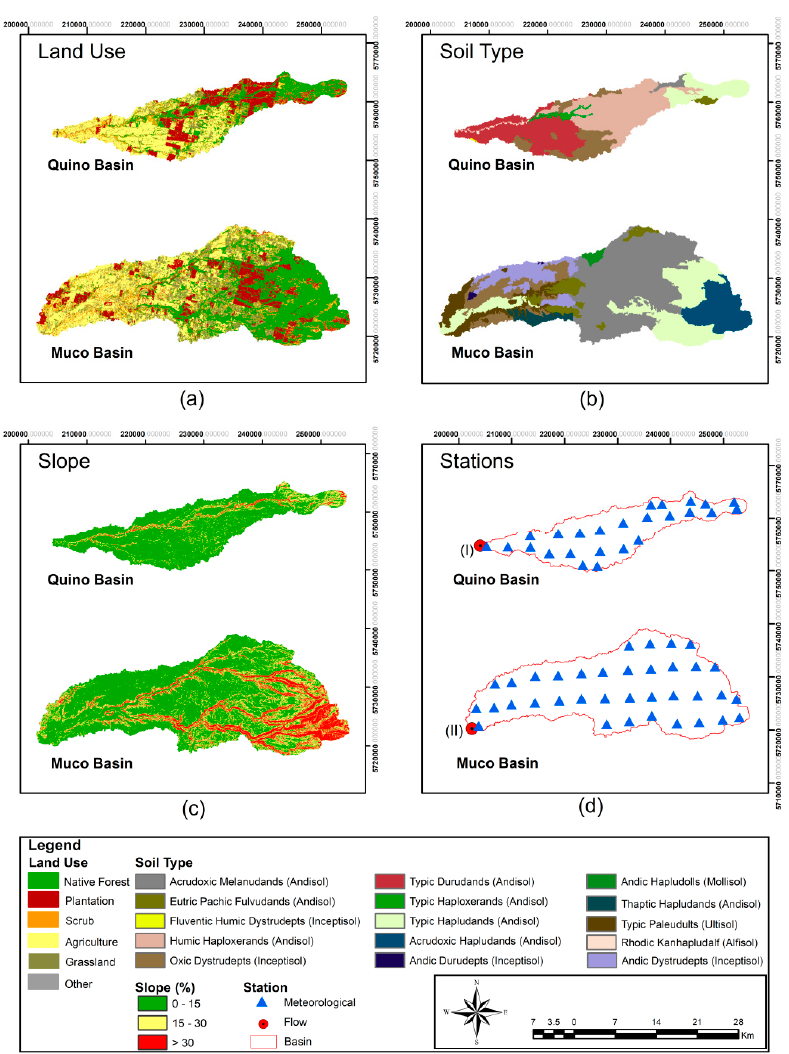
Figure 2. Data used in SWAT to delimit the sub-basins, micro-basins and hydrological response units (HRU). ( a ) Land use, ( b ) soil type, ( c ) slope and ( d ) location of climatic information and fluviometric stations: (I) Rio Quino en Longitudinal and (II) Rio Muco en Puente Muco.